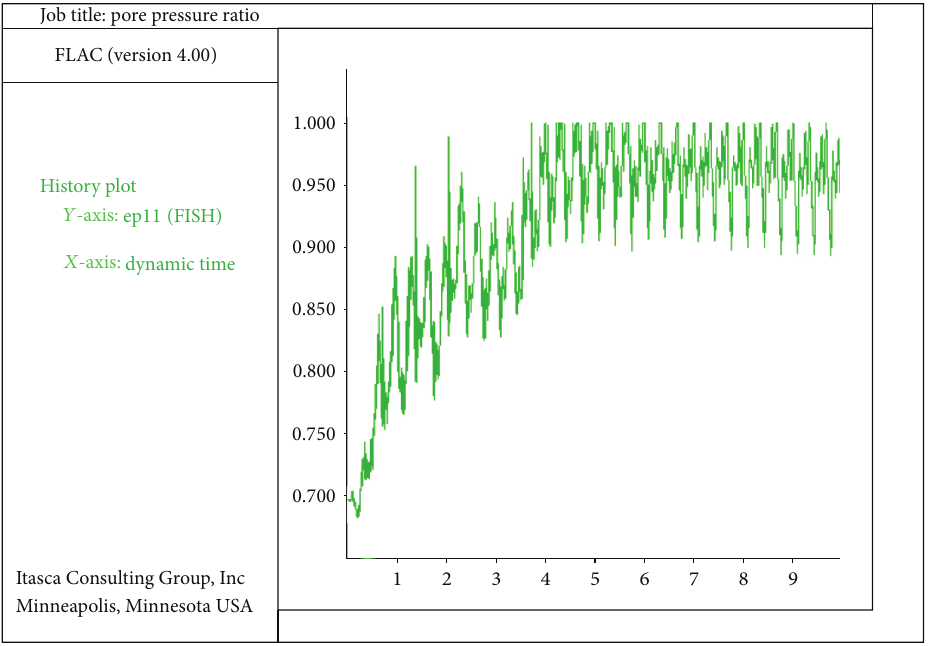
Figure 5: Ratio of pore water pressure versus time for the element on the back of the quay wall (time: seconds).